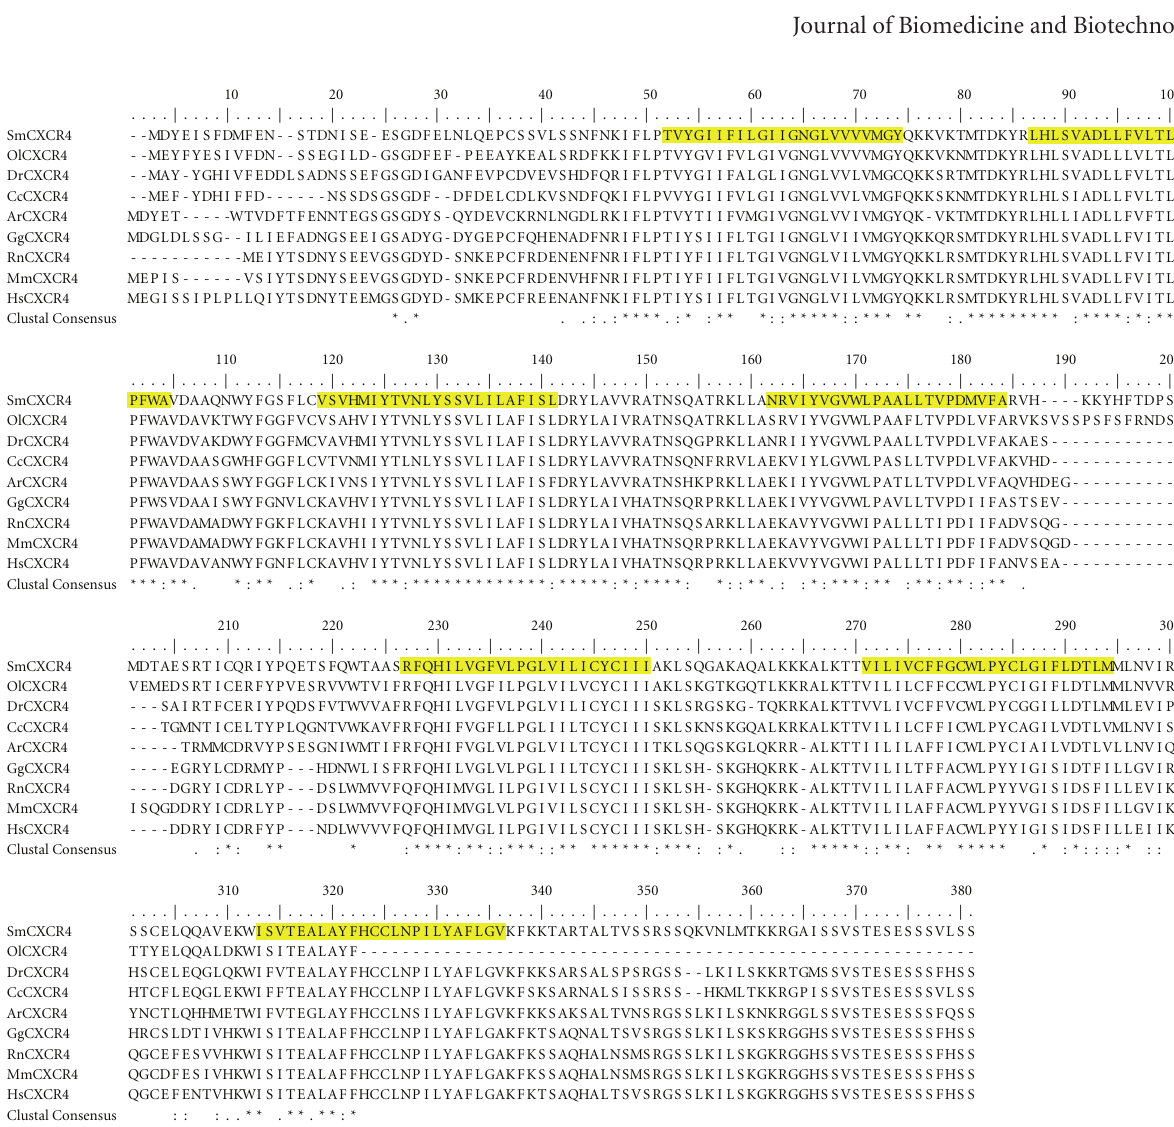
Figure 1: Alignment of deduced amino-acid sequences of turbot CXCR4 with others via ClustalX 1.8. Receptor designations: Sm— S. maximus , Ol— O. latipes , Dr— Danio rerio , Cc— Cyprinus carpio , Ar— Acipenser ruthenus , Gg— Gallus gallus , Rn— R. norvegicus , Mm— Mus musculus , Hs— Homo sapiens . Symbols: ∗ , identical residues in all sequences; :, conserved substitutions; ., semiconserved substitutions; -, gaps introduced during the alignment process. Seven transmembrane domains of CXCR4 are